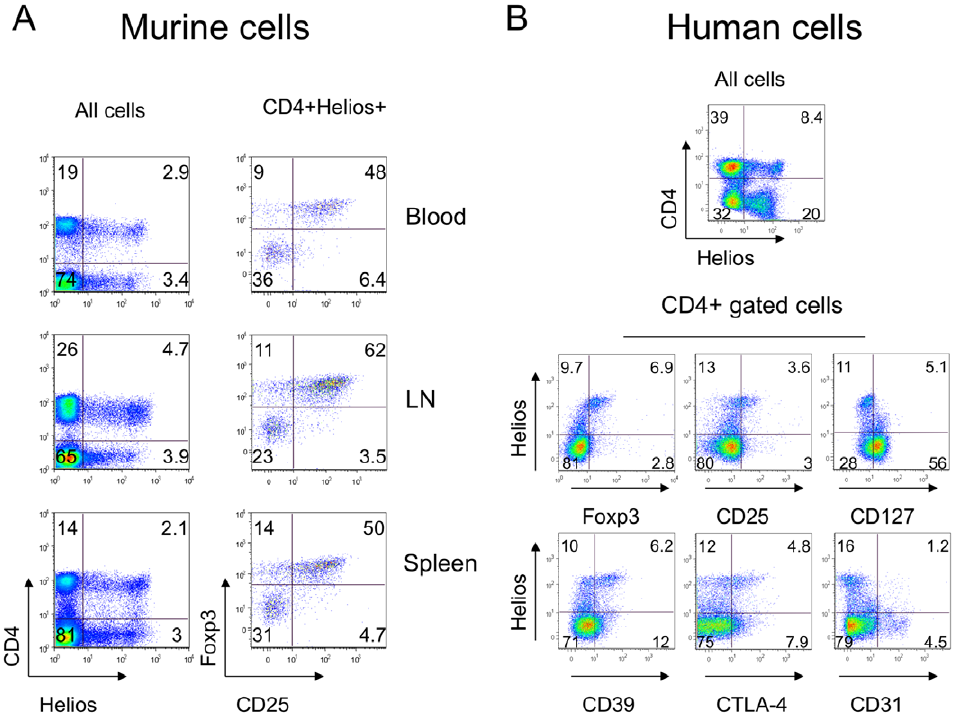
Figure 1. Helios expression was not restricted to CD4 cells, but among CD4 + cells correlated with Treg-associated markers. (A) Expression of Helios in murine lymphocytes (left column) and CD25 + Foxp3 + co-expression in CD4 + Helios + gated subsets (right column) of blood (top), lymph nodes (middle) and spleen (bottom). (B) Expression of Helios in human lymphocytes (top) and co-expression of Helios with Treg- associated markers in cells gated for CD4 expression. Right column, bottom row shows absence of correlation between Helios and CD31, a marker of recent thymic emigrants cells. Data are representative of 5 experiments. doi:10.1371/journal.pone.0024226.g001 PLoS ONE |